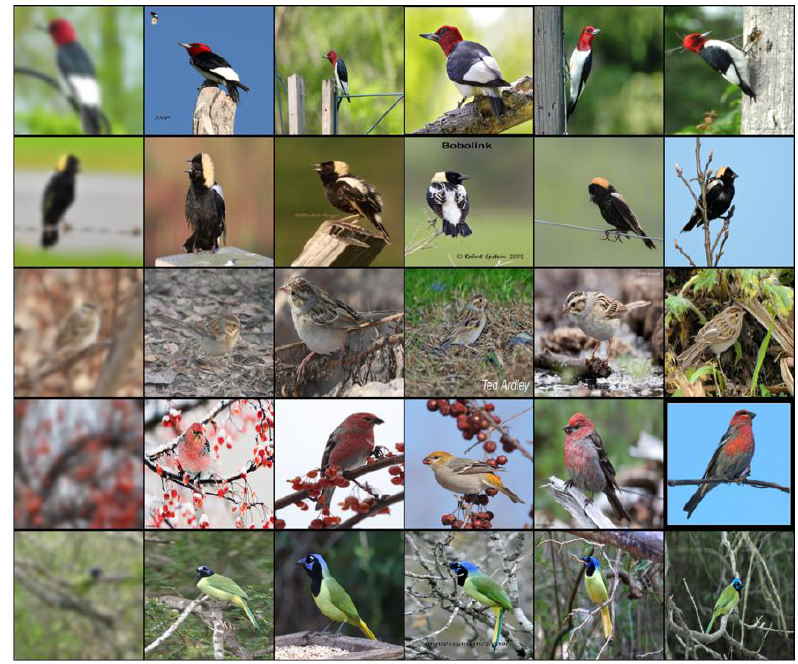
Figure 6. Top 5 retrieval results on aggressive resolution reduction samples from the CUB200-2011 dataset. The first image in each row is the query image.